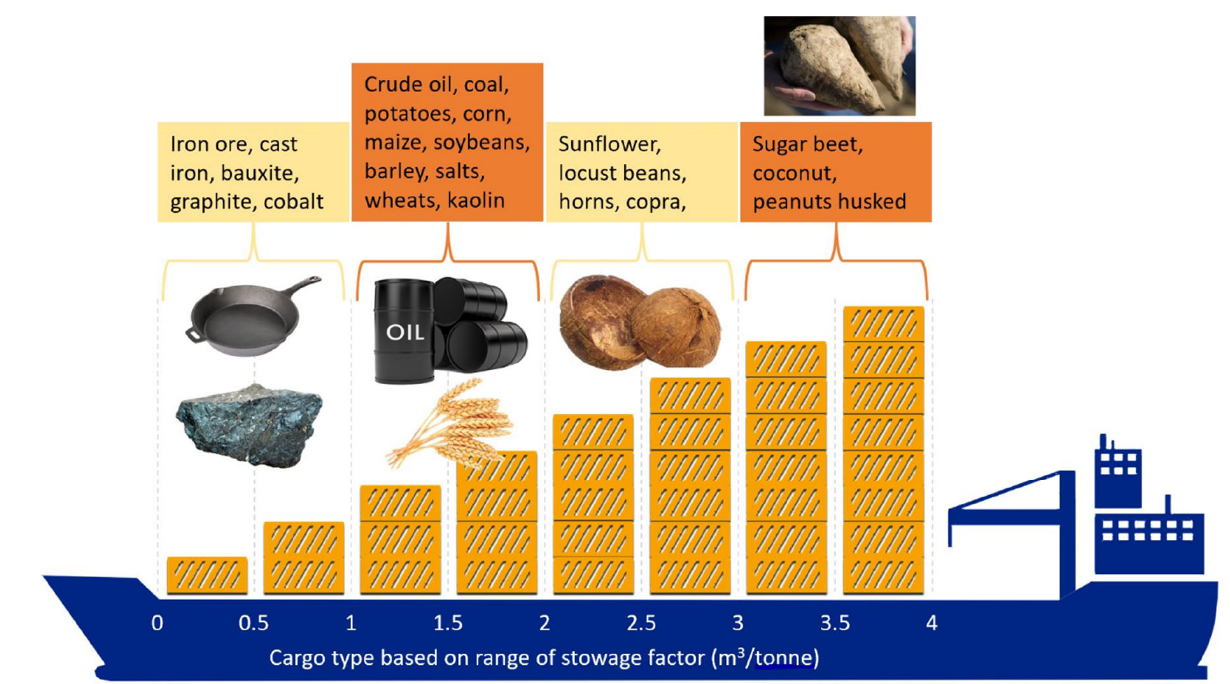
Figure 4. Typical cargos and their stowage factor [26].